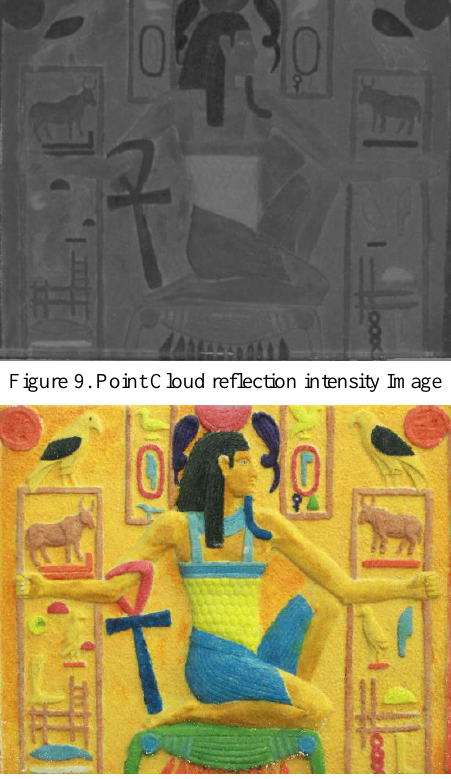
Figure 10.Point Cloud RGB Image 2. The result of SIFT matching between global image and point cloud RGB image is shown in figure 11;